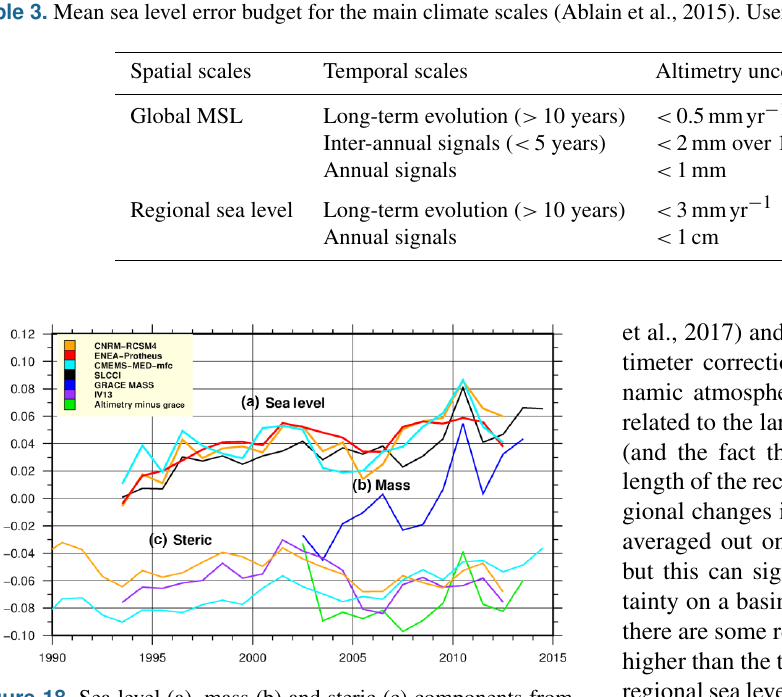
Figure 18. Sea level (a), mass (b) and steric (c) components from SL_cci and GRACE observations and from models. The colour in- dicates the source, the location in the figure (top, middle or bottom) indicates the type of product (sea level, mass or steric component for the model